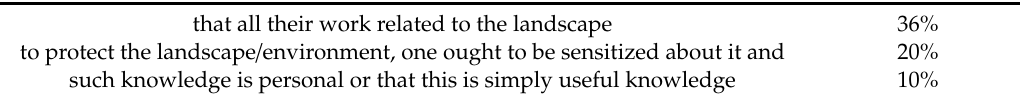
Table 4. Reasons for the importance of landscape courses taught, according to Greek engineering students (2nd research